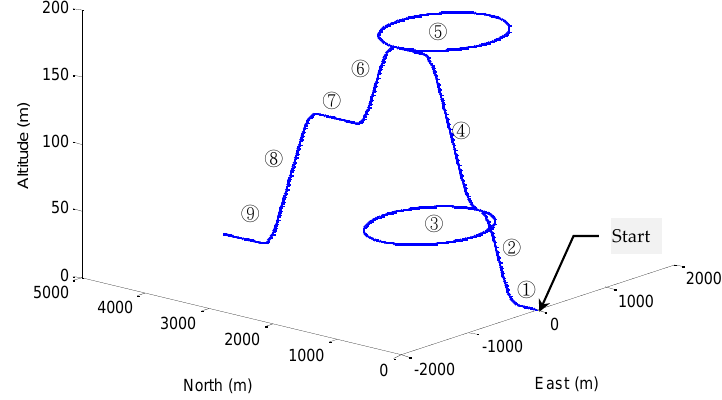
Figure 10. Three-dimensional vehicle trajectory for Scenario Figure 10. Three - dimensional vehicle trajectory for Scenario 2. Table 6. Description of the vehicle motion for Scenario 2.